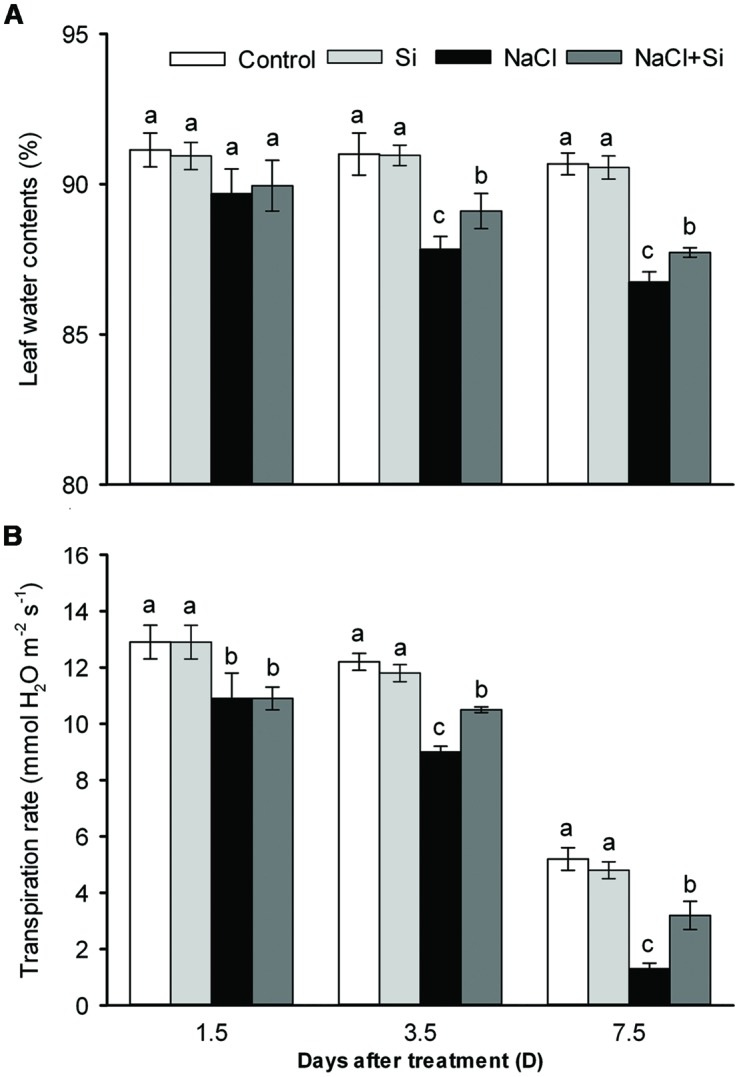
Effects of silicon (0.83 mM) and salt stress (65 mM) on leaf water content (A) and transpiration rate (B). All parameters were measured after 1.5, 3.5, and 7.5 days of salt treatment. Vertical bars represent the standard deviations (n = 3). Different letters at the same time point represent significant differences (p < 0.05) between the treatments.